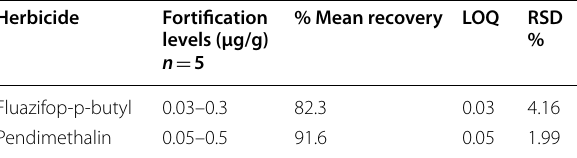
n number of replicates = RSD relative standard deviation =